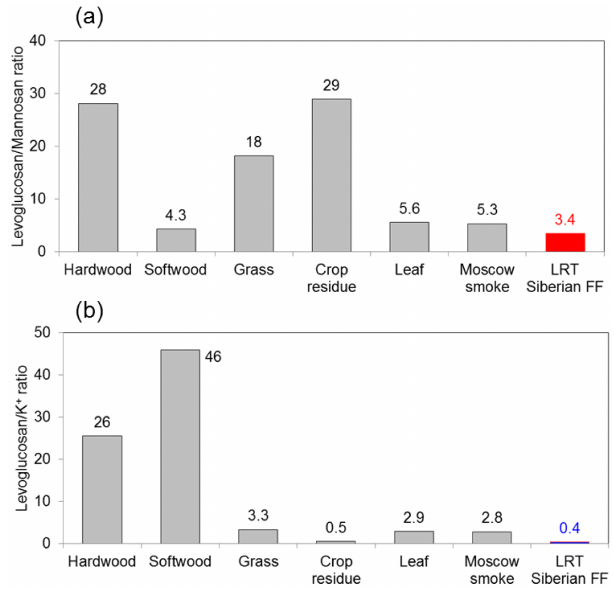
Figure 12. (a) Levoglucosan to mannosan ratios and (b) levoglu- cosan to K + ratios obtained from previous chamber studies, ex- treme smoke episodes in Moscow, Russia in summer 2010, and the Siberian forest fire episode. Hardwoods: Fine et al. (2001, 2002, 2004a, b), Schauer et al. (2001), Engling et al. (2006), Schmidl et al. (2008a), Gonçalves et al. (2010), Bari et al. (2009); Soft- woods: Fine et al. (2001, 2002, 2004a, b), Schauer et al. (2001), Engling et al. (2006), Hay et al. (2002), Schmidl et al. (2008a), Goncalves et al. (2010), Iinuma et al. (2007), Cheng et al. (2013); Grass: Sullivan et al. (2008); Crop residue: Sullivan et al. (2008), Oanh et al. (2011), Sheesley et al. (2003), Engling et al. (2009), Cheng et al. (2013); Leaf: Schmidl et al. (2008b); Moscow smoke: Popovicheva et al. (2014); LRT Siberia FF: This